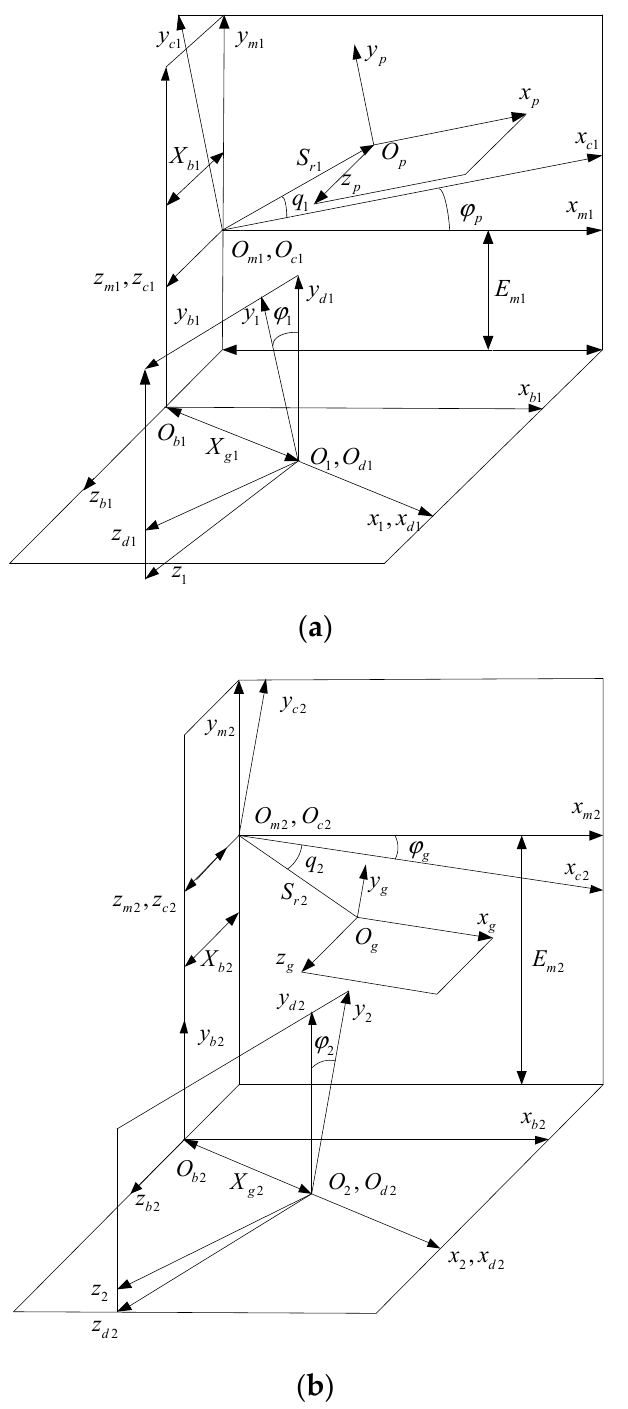
Figure 1. Machining coordinate system of SBG. ( a ) The machining coordinate system of the pinion and ( b ) the machining coordinate system of the gear.